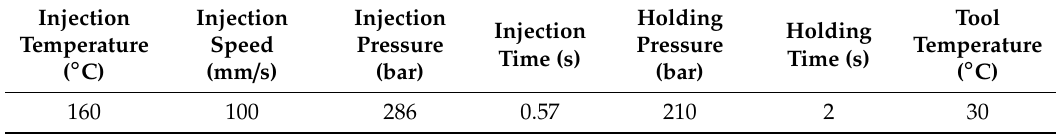
Table 1. Process parameters used for CIM of alumina compounds with filler degrees of 55 and 58